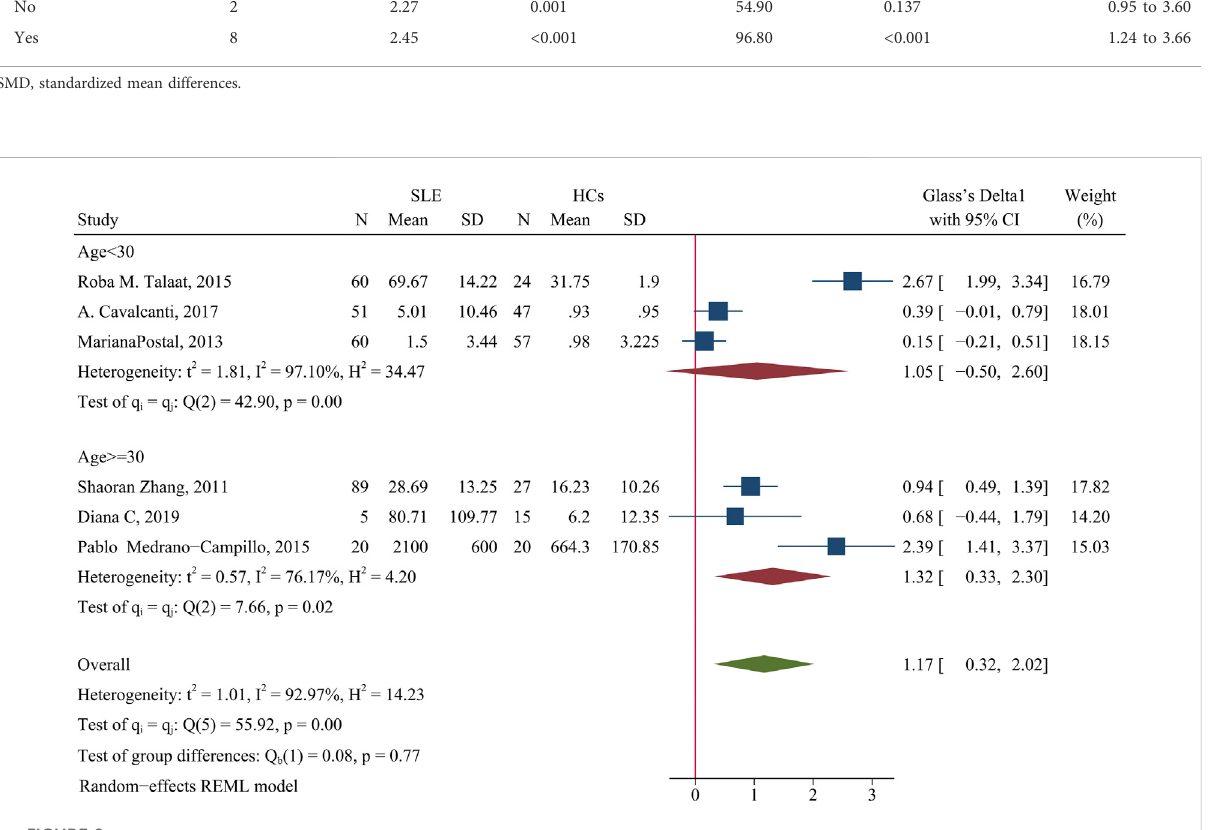
FIGURE 9 Forest plot of the concentration change of IL-6 in SLE patients compared with HCs. The overall results (bottom) show the meta-analysis of 6 studies, and the other two results show meta-analyses of subgroups according to patient age. SLE, systemic lupus erythematosus; HCs, healthy